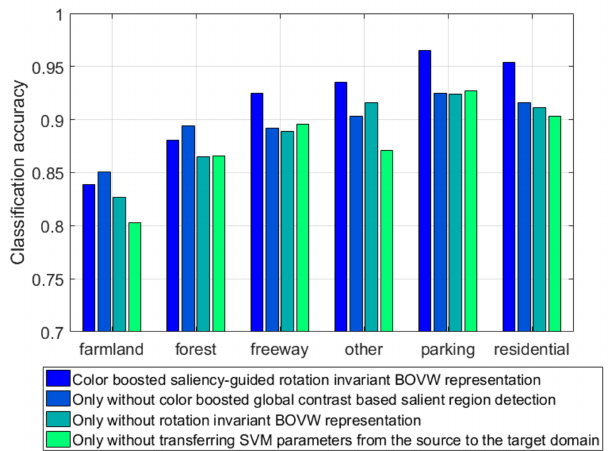
Figure 15. Producers’ accuracies with the SIRI-WHU dataset for four different methods.